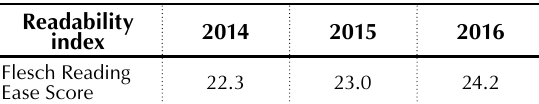
Table 5. Development of the integrated reporting readability